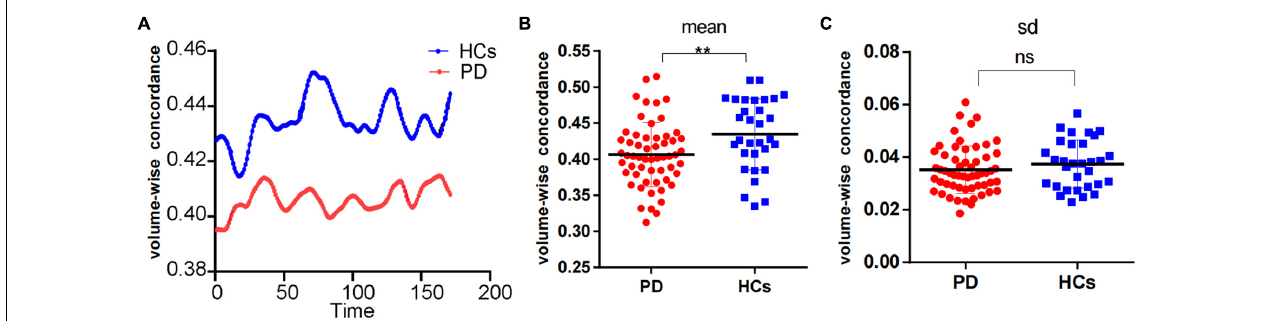
FIGURE 1 | Comparison of volume-wise concordance indices between PD patients and HCs. (A) Volume-wise concordance time series of the mean value in PD patients and HCs. (B) Comparison of mean volume-wise concordance indices. (C) Comparison of the SD of volume-wise concordance indices. PD, Parkinson’s disease; HCs, healthy controls. SD, Standard deviation. ** P < 0.01; ns, no significance.